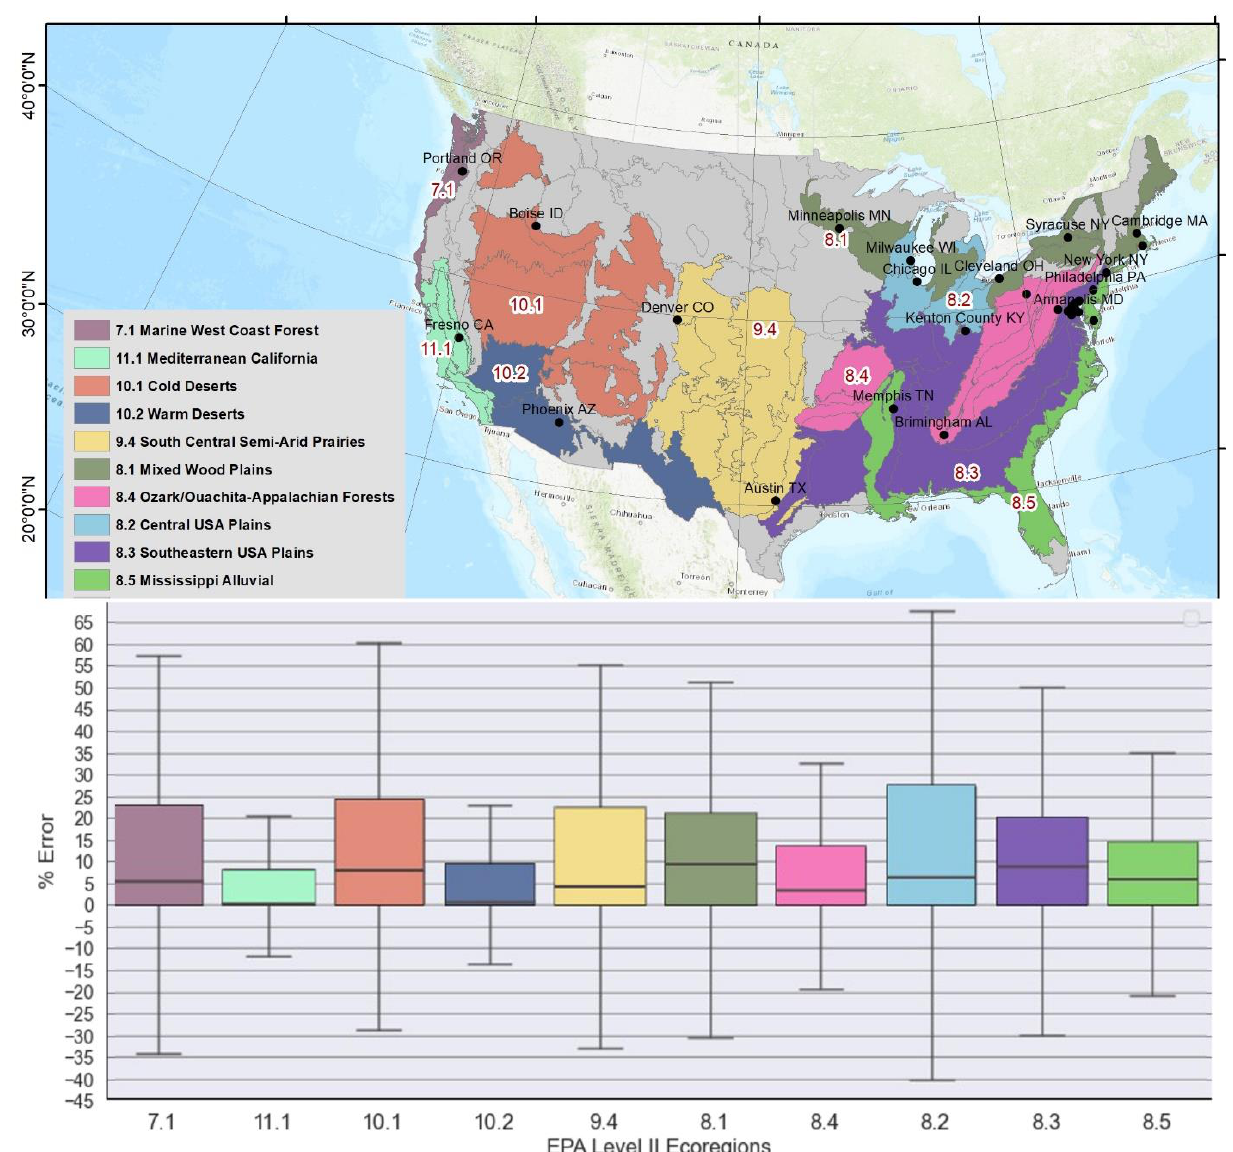
Figure 4. Selected Environmental Protection Agency Level II ecoregions [28] and average National Land Cover Database-Tree Canopy error (deviation by % when compared to high-resolution derived data) by EPA Level II ecoregions.